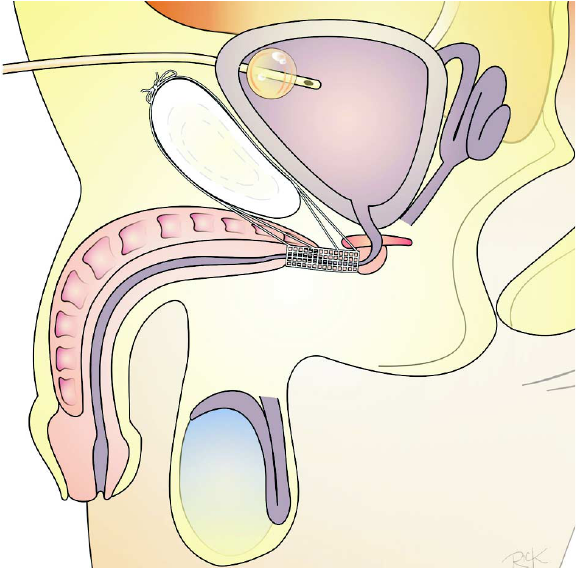
Figure 3 – Schematic drawing of a schematic sagital section showing how the sutures are passed and fixed anteriorly and posteriorly to the